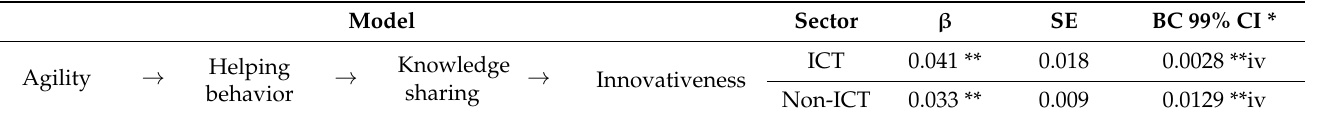
Table 8. Serial mediating